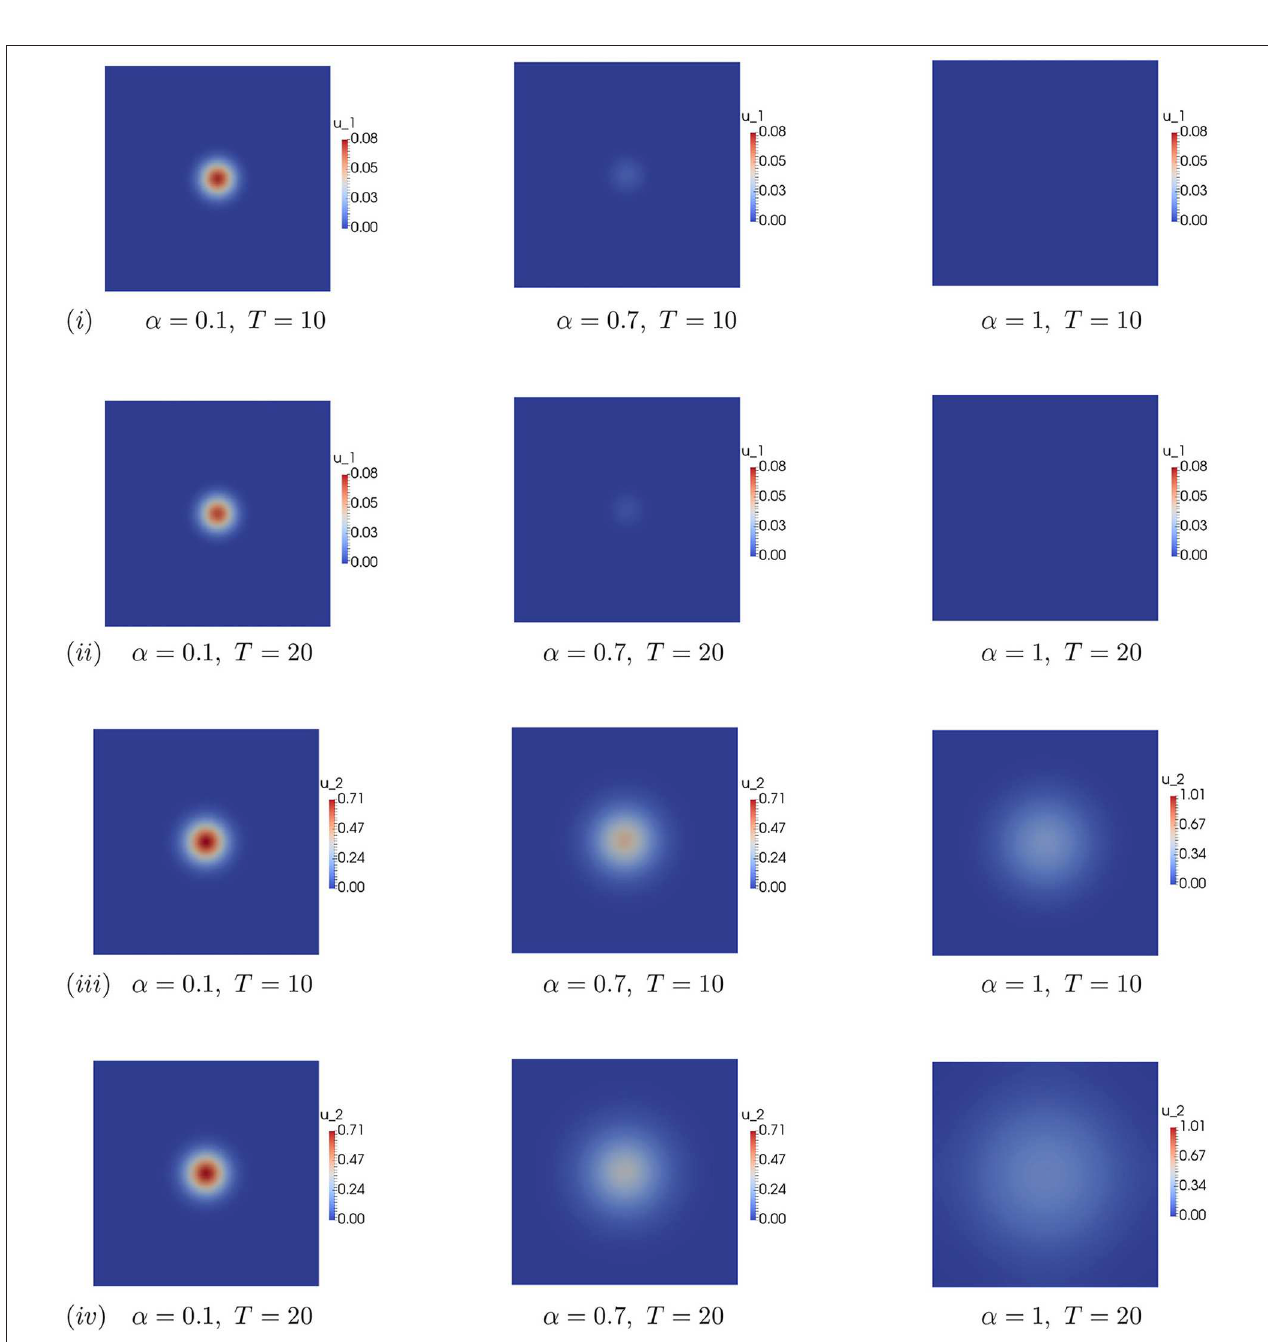
FIGURE 1 | Evaluation of u 1 and u 2 at T = 10, 20 with the different values of α = 0.1,0.7, and 1.